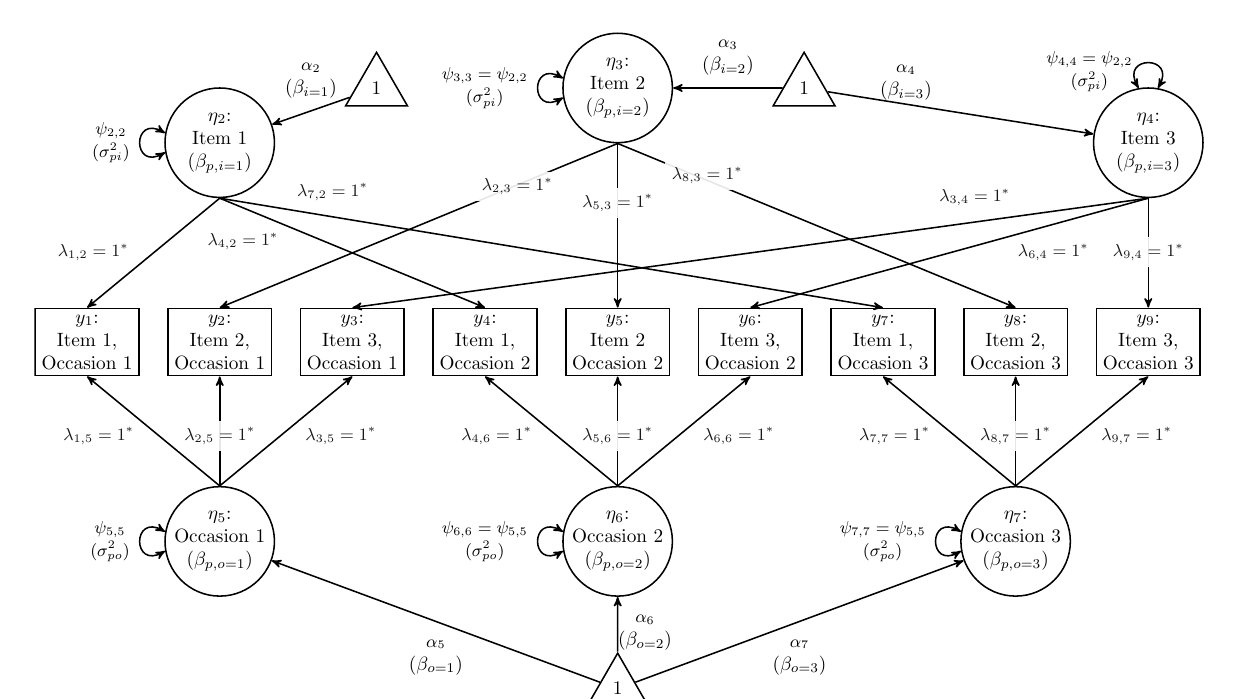
Figure 2. Two layers of a path diagram depicting a p × i × o GT design represented as a CFA model with 9 indicators (3 items × 3 occasions). Each CFA variable and parameter are labeled using LISREL notation, accompanied by GT notation in parentheses. Identification constraints on the mean structure are listed in Table 1. ( a ) The Person facet (of differentiation) is the first common factor. Residuals capture the highest-order term, confounded with any other source(s) of error. Intercepts of indicator residuals represent the interaction between all facets of generalization. ( b ) The facets of generalization interact with the Person facet (captured by the common factors), and their main effects are captured by the factor